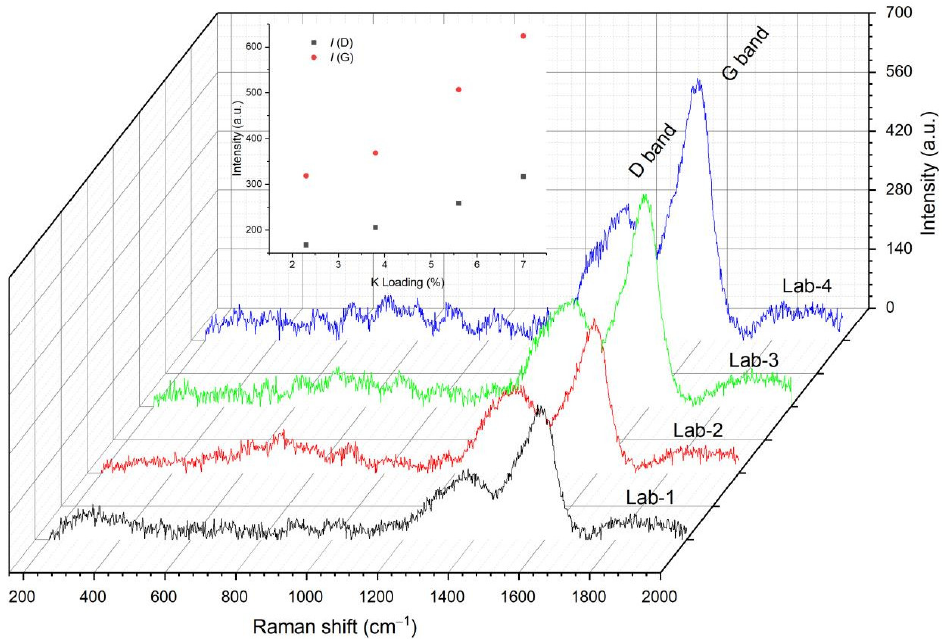
Figure 10. Raman spectra of four spent catalysts. The inset pattern is the intensity of the D band ( I (D)) and G band ( I (G)) plotted with potassium loading.